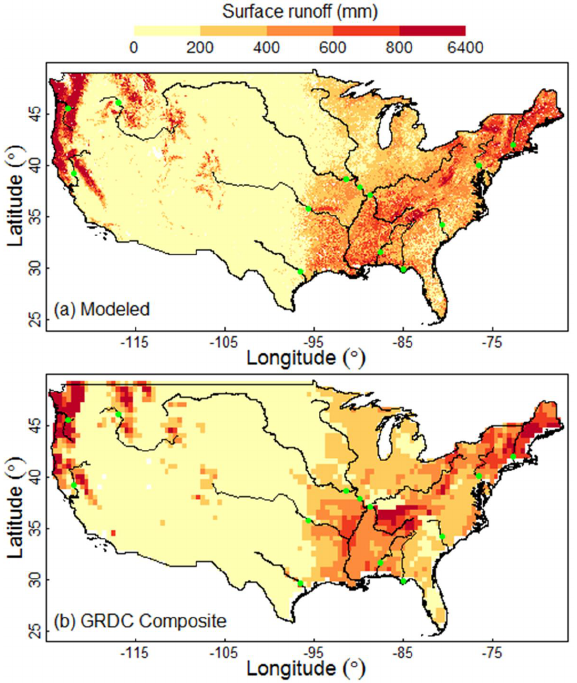
Fig. 7. (a) The LH-simulated annual surface runoff at 2.5 arc-min grid cells and (b) the GRDC composite annual runoff at 0.5-degree grid cells (Fekete et al., 2002) for the conterminous US.